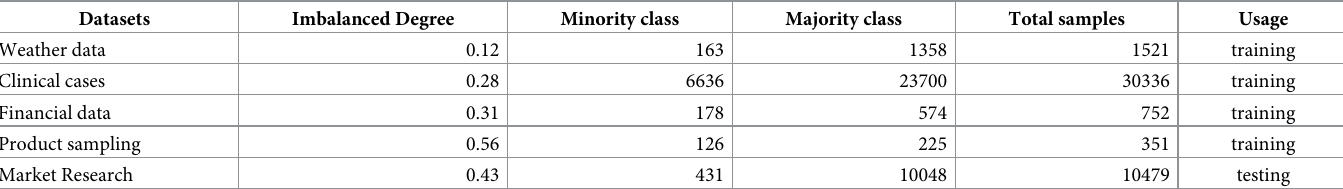
Table 2. The Datasets for training and testing algorithms.